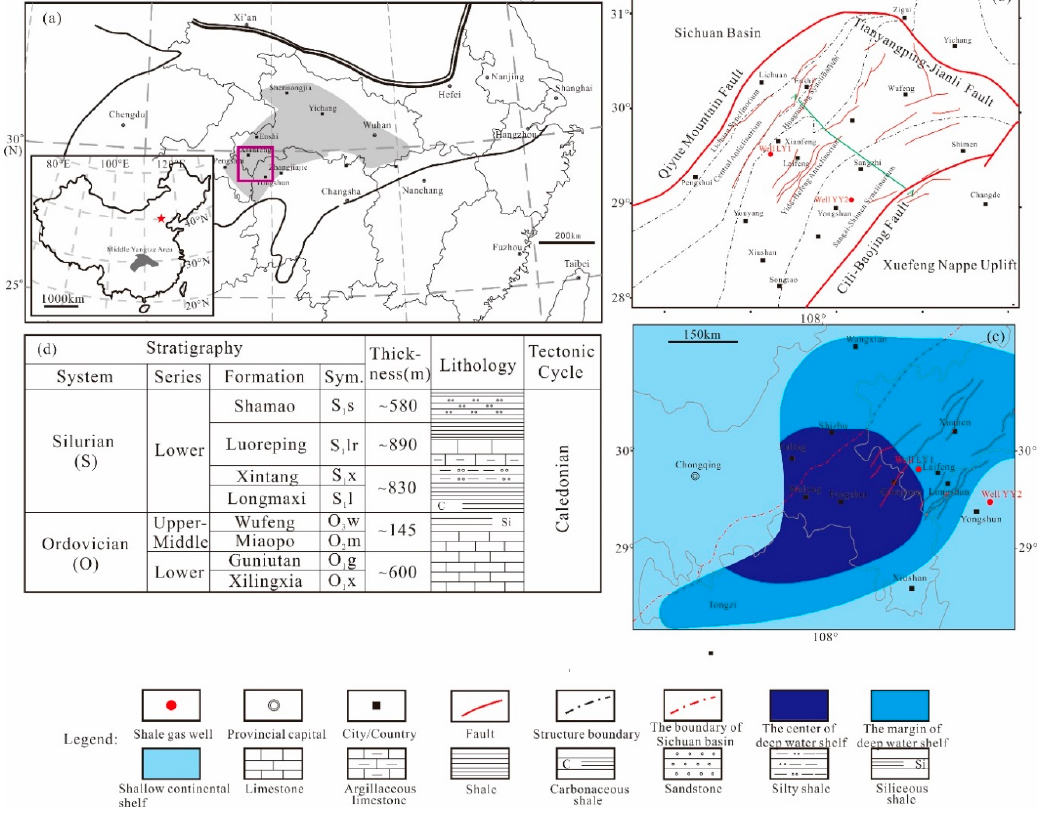
Figure 2. ( a ) The location of the study area in China; ( b ) the tectonic framework in the study area; ( c ) the sedimentary environment of the Longmaxi formation in the study area; ( d ) Simplified stratigraphic units in the middle Yangtze area and the Upper Ordovician Wufeng and the bottom of the lower Silurian Longmaxi formations. The wavy lines represent unconformities. Sym. = symbol.